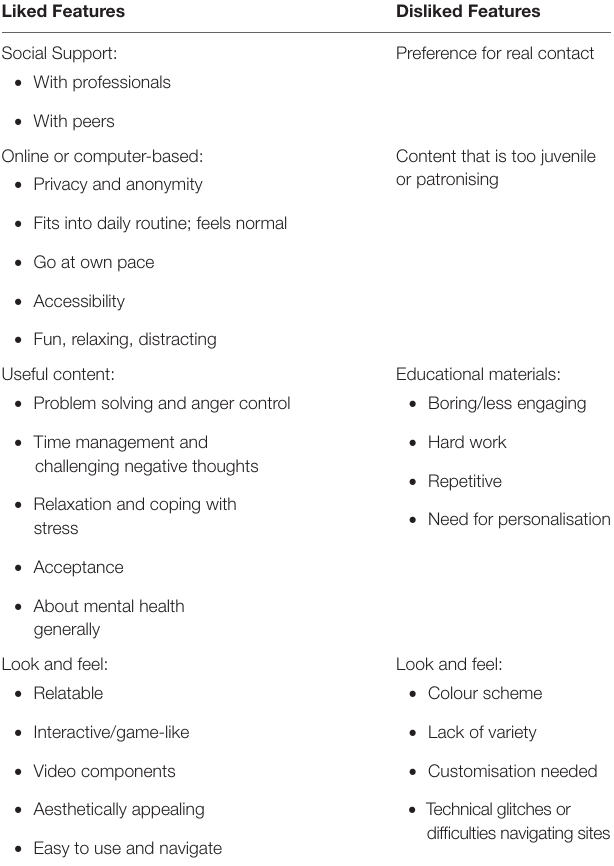
TABLE 6 | Liked and disliked features of